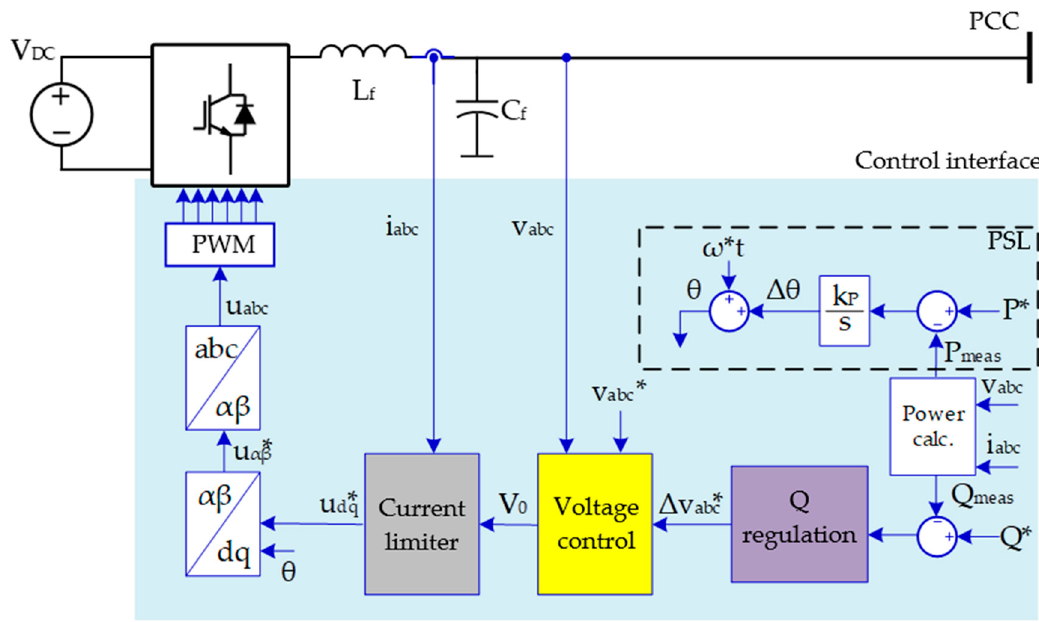
Figure 15. Grid-forming power synchronization control [56].